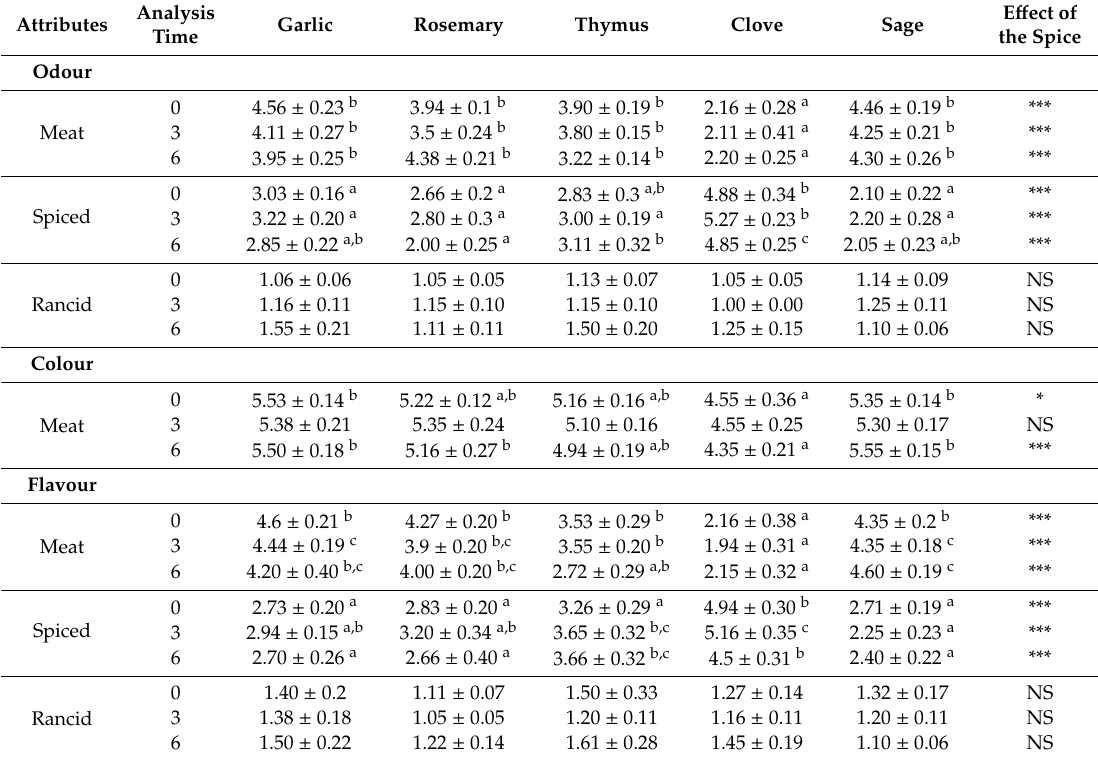
Table 4. E ff ect of type of spice added on sensory attributes (mean ± s.e.) of cooked lamb meat burgers from Formula LNB (2 / 3 leg + 1 / 3 neck and breast meat) under aerobiosis conditions for up 0 to 6 days.